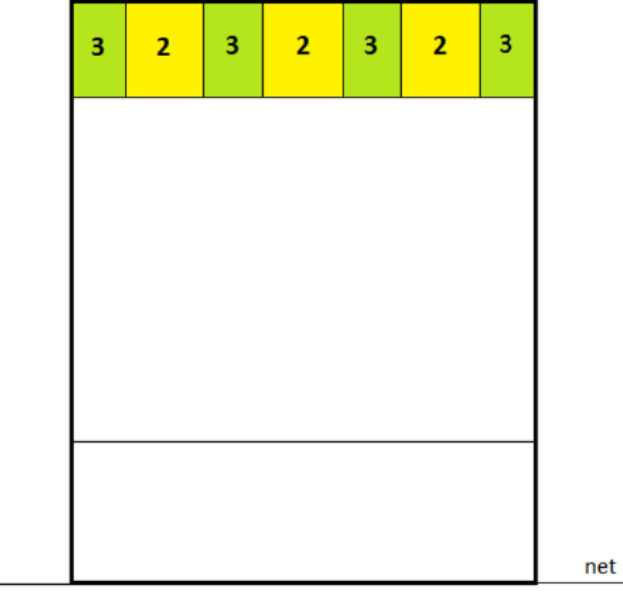
Figure 5. Division of the court (9 m × 9 m) into point zones to assess the accuracy of the attack.